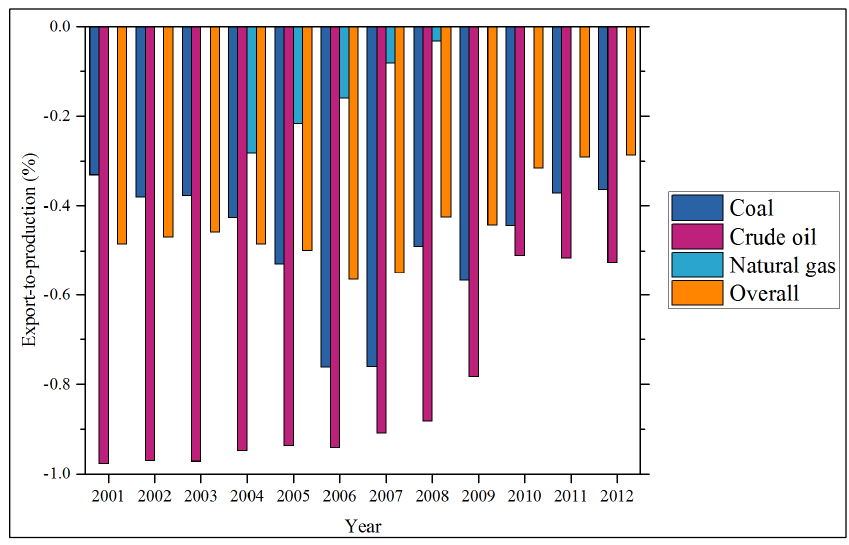
Figure 40. Vietnam: export to